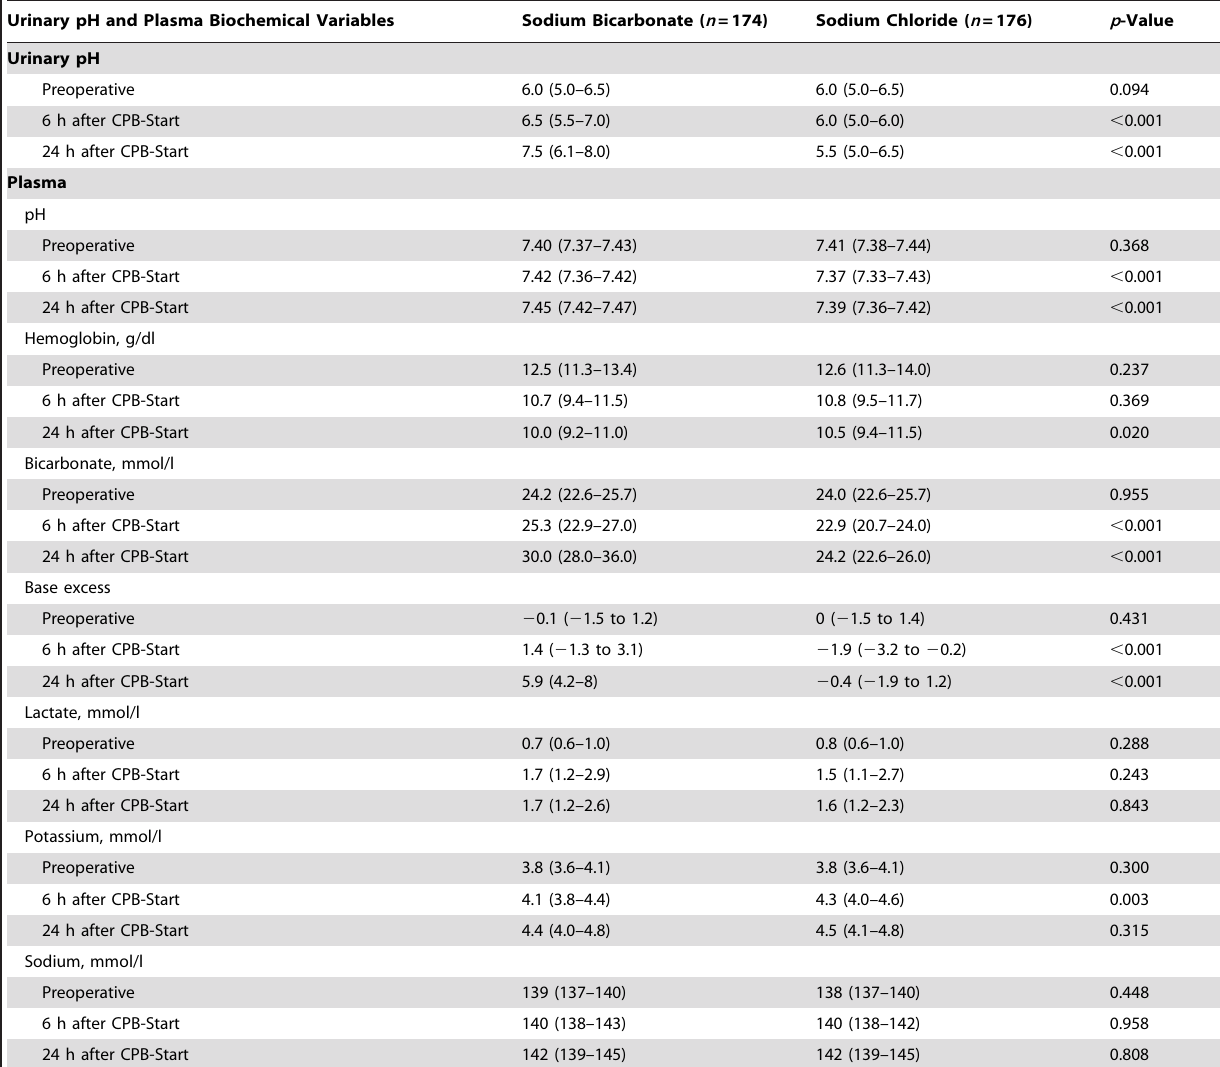
Urinary pH and Plasma Biochemical Variables Sodium Bicarbonate ( n